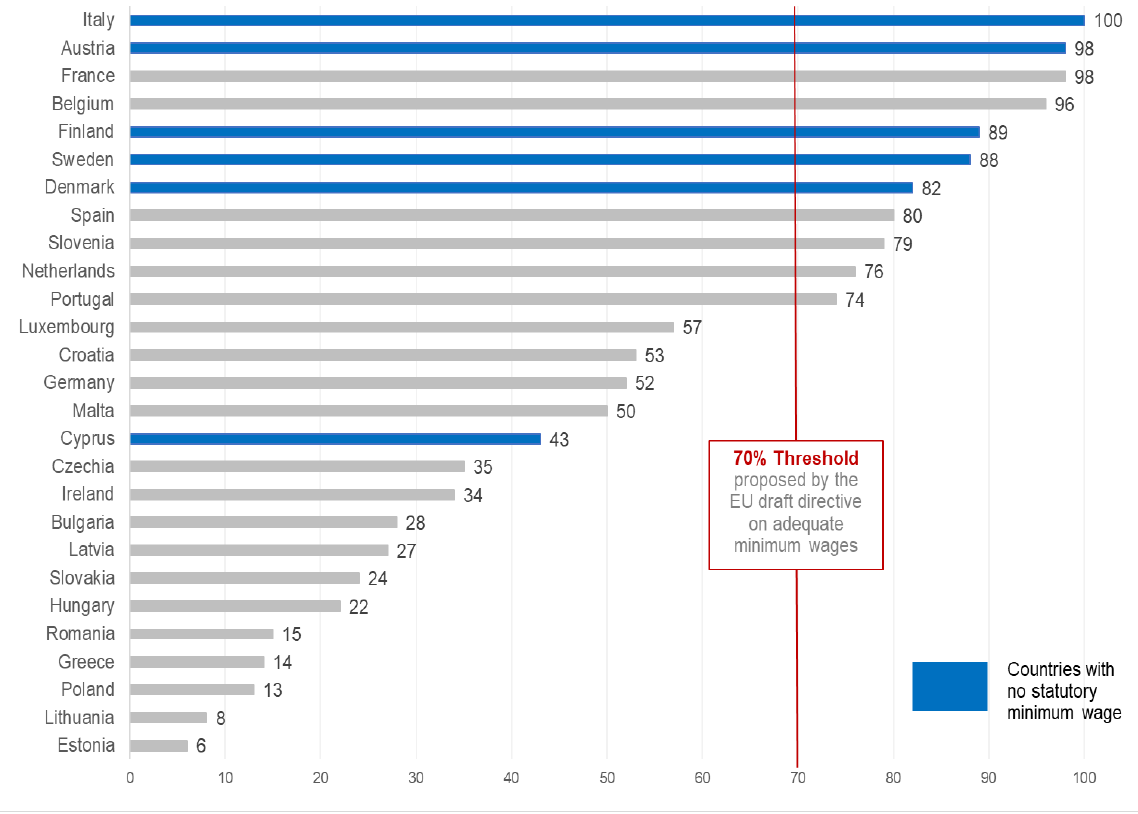
* 2019 or most recent value